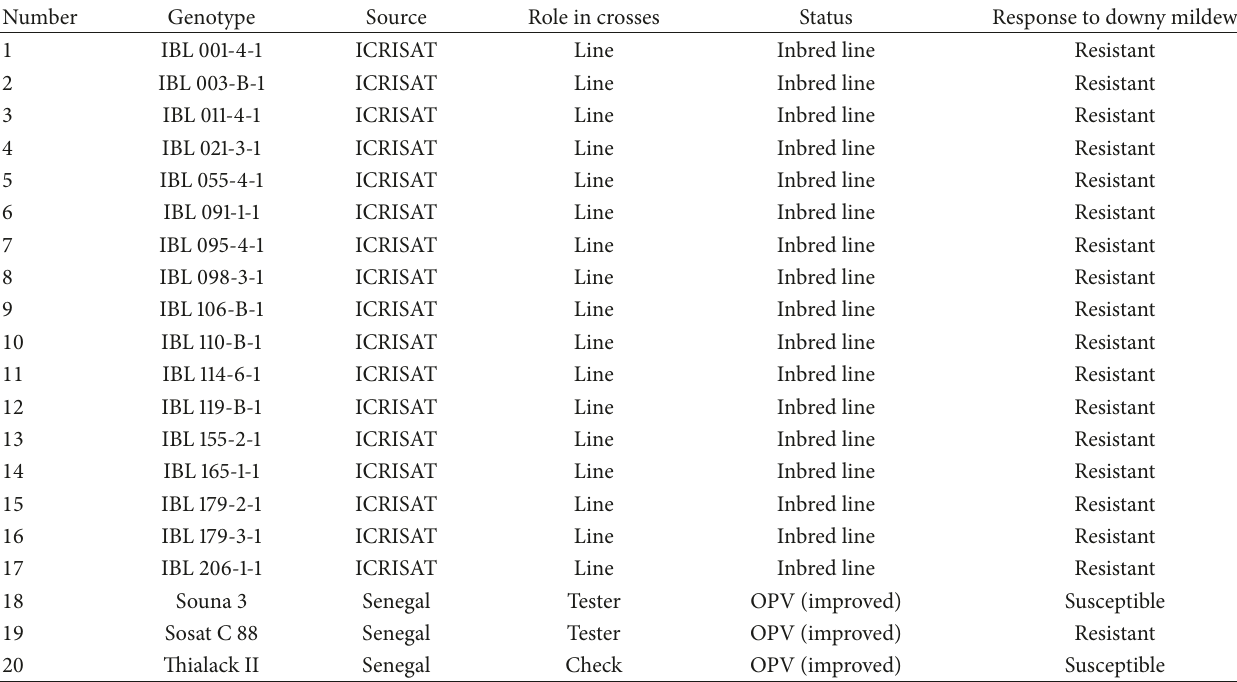
Table 1: List of parental lines and check used in the